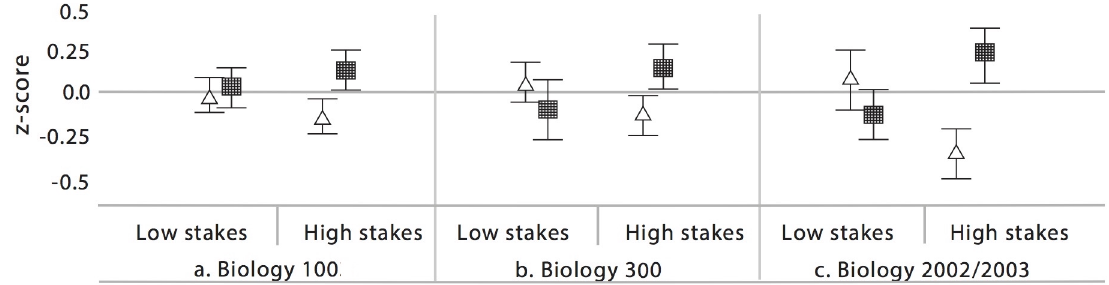
Fig 2. Gender-based performance on combined exam scores for three casestudies: a. Biology 100; b. 300; and c. the Biology 202/203sequence. Individual Z-scores for each exam are averagedand combinedinto total exam performance for women (triangles) and men (squares) across two semesters—for each course, one semester in which exams contributed over 40% of the course grade (“high stakes”) and one semester in which exams contributedless than 40% of the course grade (“low stakes”). There was a significantgenderx semester interactioneffect for performance in all three cases (p < 0.05;Tables F-H in S1